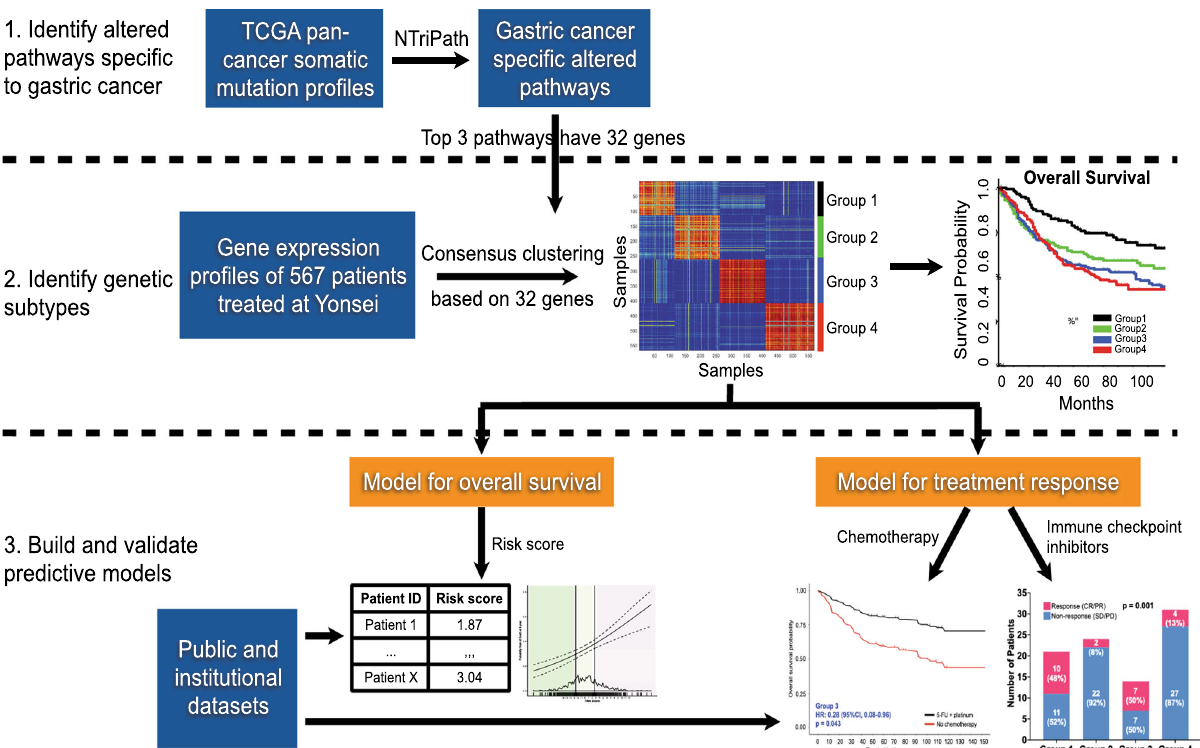
Fig. 1 Work fl ow of the current study. The somatic mutation pro fi les of 6681 patients from 19 different cancers from TCGA were inputted into NTriPath to identify pathways that were altered speci fi cally in gastric cancer. Microarray-based mRNA expression pro fi les of 567 gastric cancer patients were generated and inputted into NTriPath. Unsupervised clustering based on the expression of 32 member genes that comprised the top three altered pathways were used to identify molecular subtypes. The prognostic and predictive capability of the molecular subtypes were tested in multiple independent cohorts. TCGA The Cancer Genome